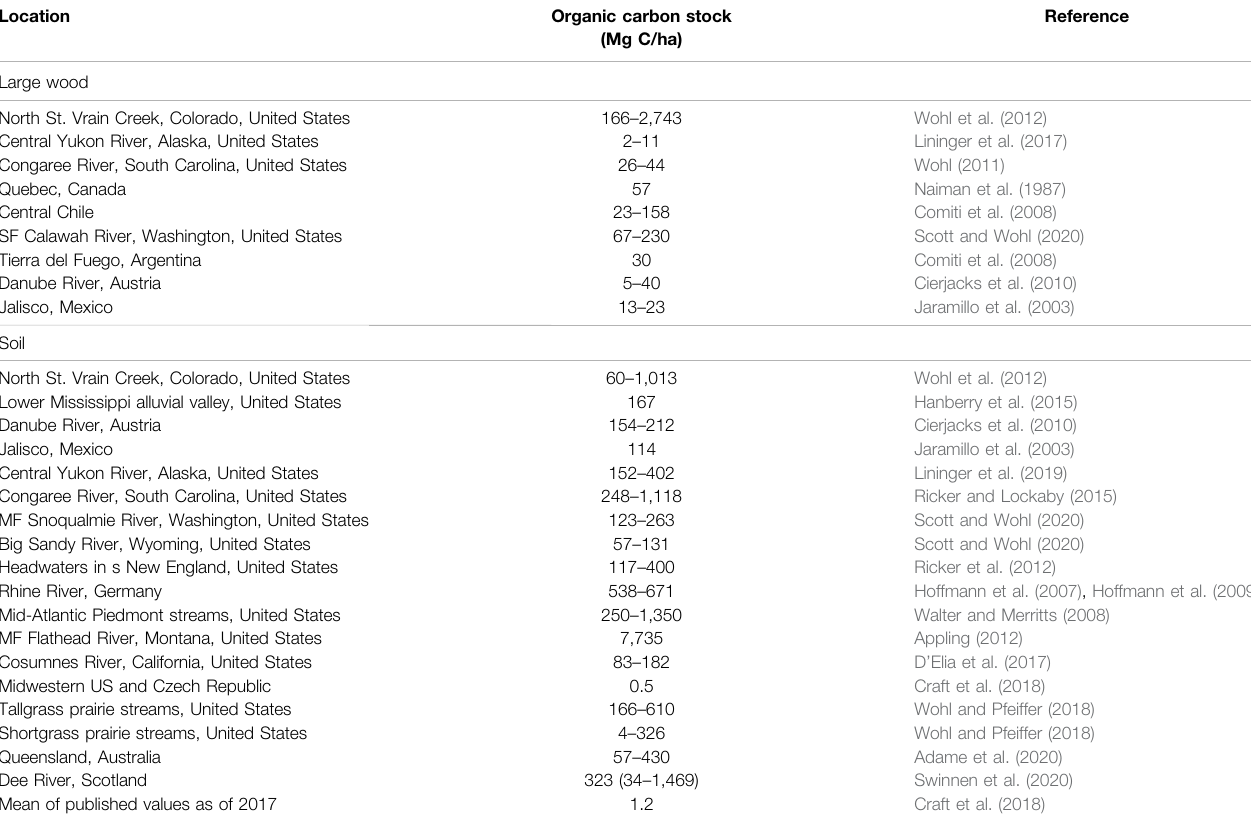
TABLE 1 | Review of published values of fl oodplain large wood and soil organic carbon stocks.